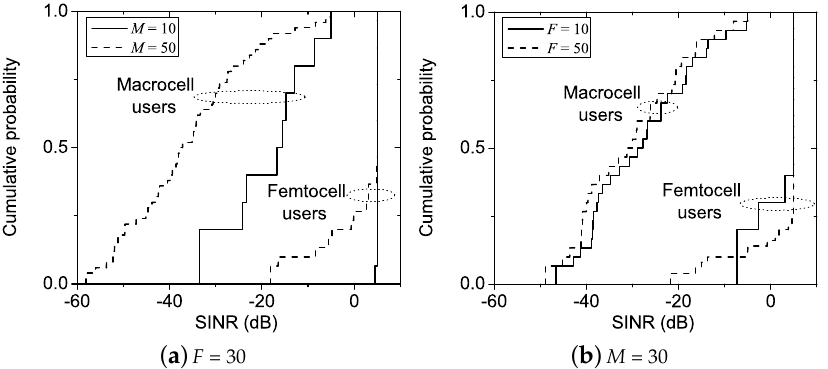
Figure 6. Probability distribution of users’ achieved SINRs under various numbers of macro- and femtocell users when handovers are not considered (the target SINR of macrocell users and that of femtocell users are − 5 dB and 5 dB, respectively).